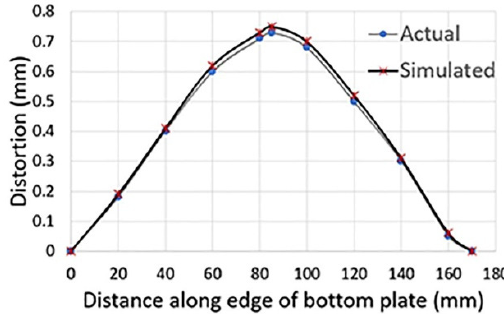
Figure 5. Actual vs . simulated distortion in edge of bottom plate.